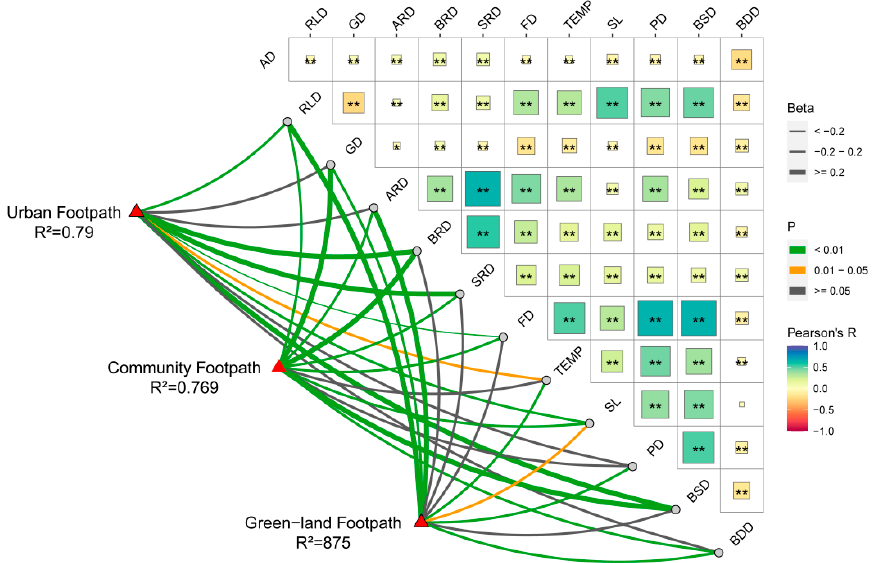
Figure 8. Differences in the influence of different footpath environments on residents’ JA. Note: “**” indicates p < 0.01, “*” indicates p < 0.05.